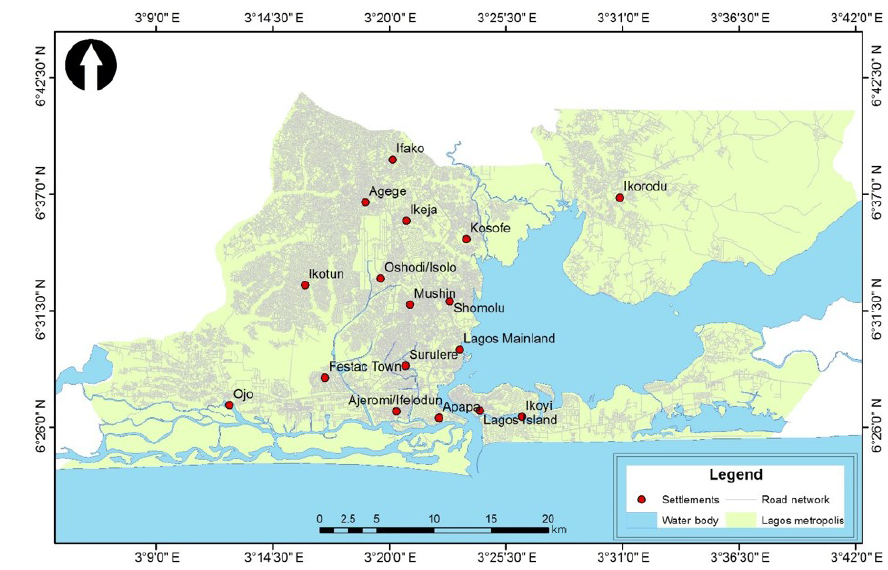
Figure 1. Lagos metropolis area. (@ LABCARS, Dept. of Geography, University of Lagos,